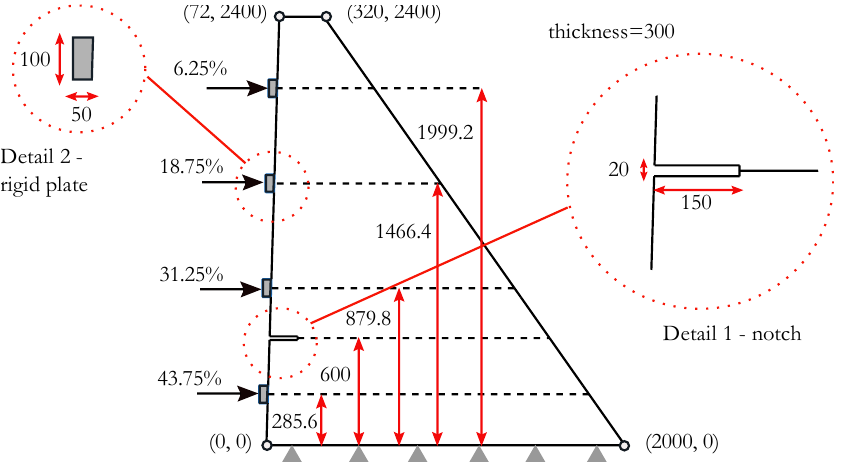
Figure 2. Geometry, boundary conditions, coordinates, and details for the finite element simulation (units: mm).